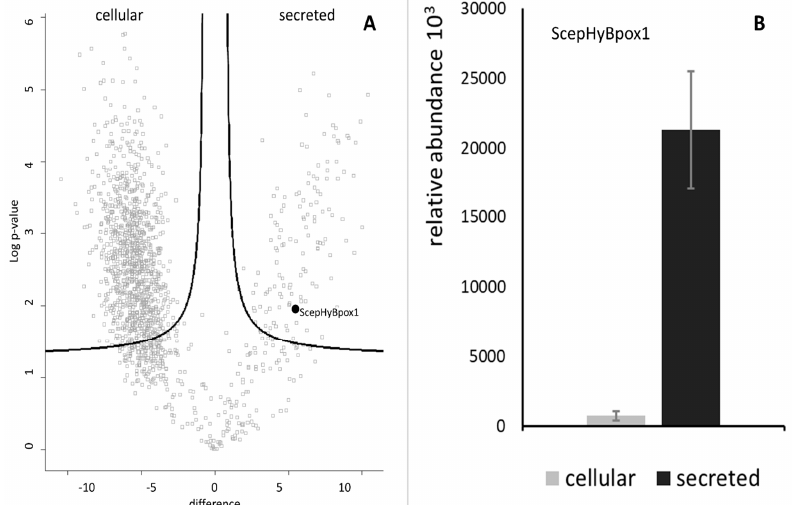
Figure 2. Identification and quantification of the peroxidase ScepHyBpox1 in the proteomic dataset. ( A ) The volcano plot shows the distribution of identified proteins according to their statistical sig- nificance (Log p -value) and magnitude of change (difference). Peroxidase ScepHyBpox1 signifi- cantly accumulated in secretome samples compared with intact cells. ( B ) Observed label-free quan- titation intensities of ScepHyBpox1 protein in cellular and secreted protein samples are depicted as means with SE error bars ( n = 3). It can be concluded that the discovered peptide fragments are distributed throughout the whole protein sequence of this peroxidase. Moreover, in Figure S2, annotated frag- mentation spectra belonging to peptides from this study identifying extracellular peroxi- dase ScepHyBpox1 are shown. From the presented cDNA-sequencing output and mass spectrometry analysis, it can be deduced that the protein sequence of ScepHyBpox1 iden- tified in the strain CBS 276.93 is completely identical to the protein sequence with acces- sion number KAF7861899 (Table S2) from the genome of a different strain, JRUF-117, where it is annotated as just a “hypothetical protein” in the automatically translated pro- teome from BioProject PRJNA494516 [9].